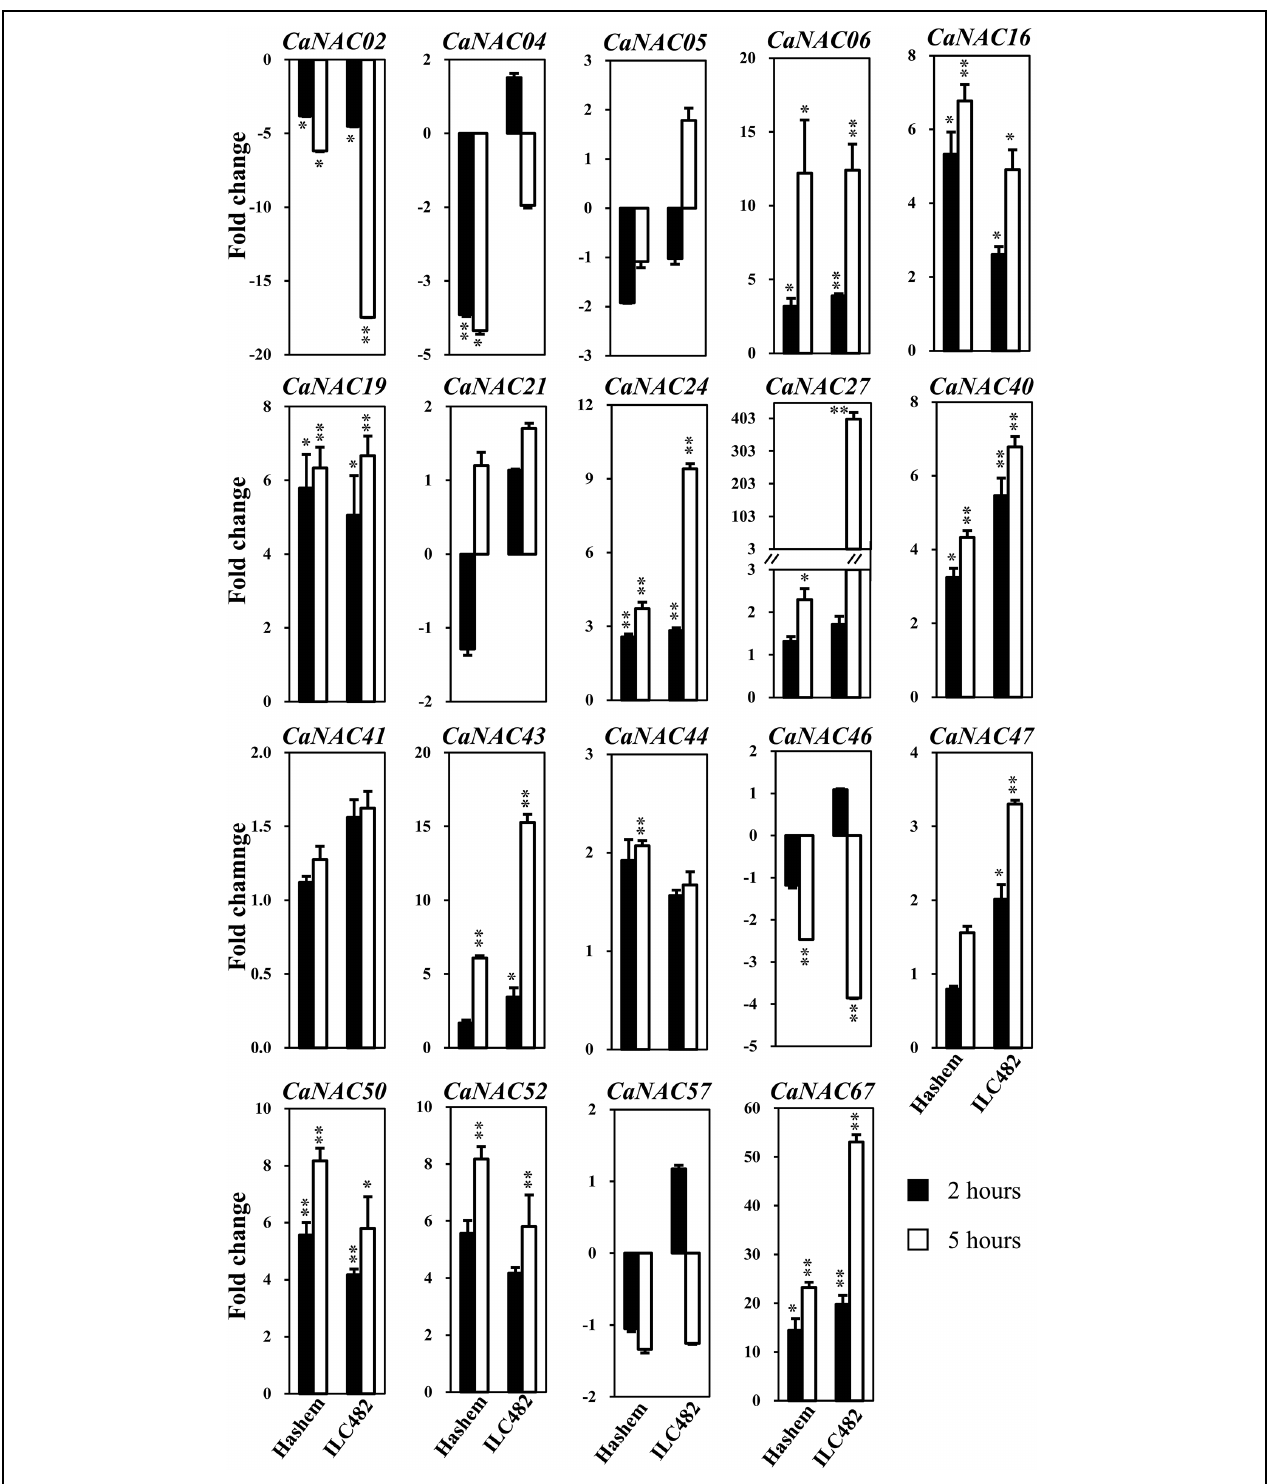
FIGURE 1 | Expression of 19 selected CaNAC genes in roots of drought-tolerant ILC482 and drought-sensitive Hashem cultivars under dehydration. Expression data of the CaNAC genes in ILC482 roots were obtained by RT-qPCR of root samples treated with well-water control or dehydration for 2 or 5 h. For convenient comparison, expression data of the